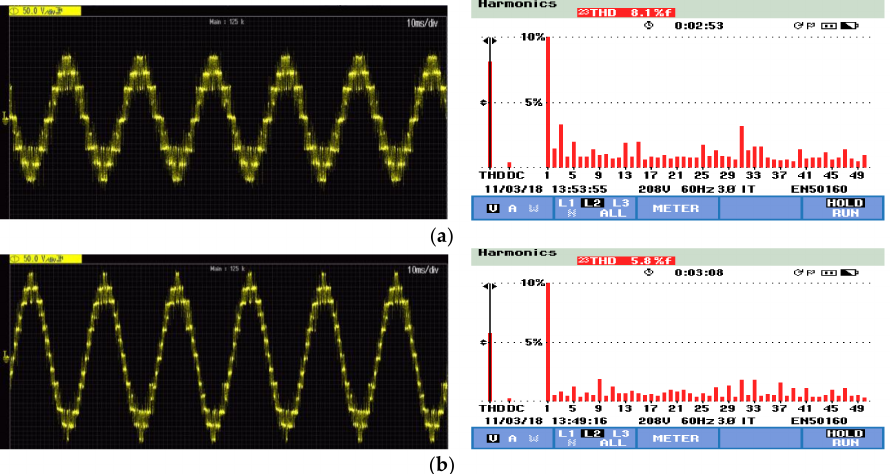
Figure 10. Output voltage and FFT results for a modulation index of ( a ) 0.65; and ( b )